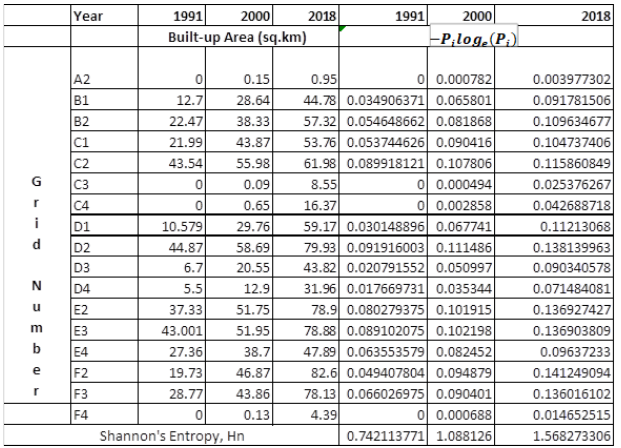
Table 3: Shannon’s entropy calculation for 17 grids over the years 1991, 2000, and 2018.